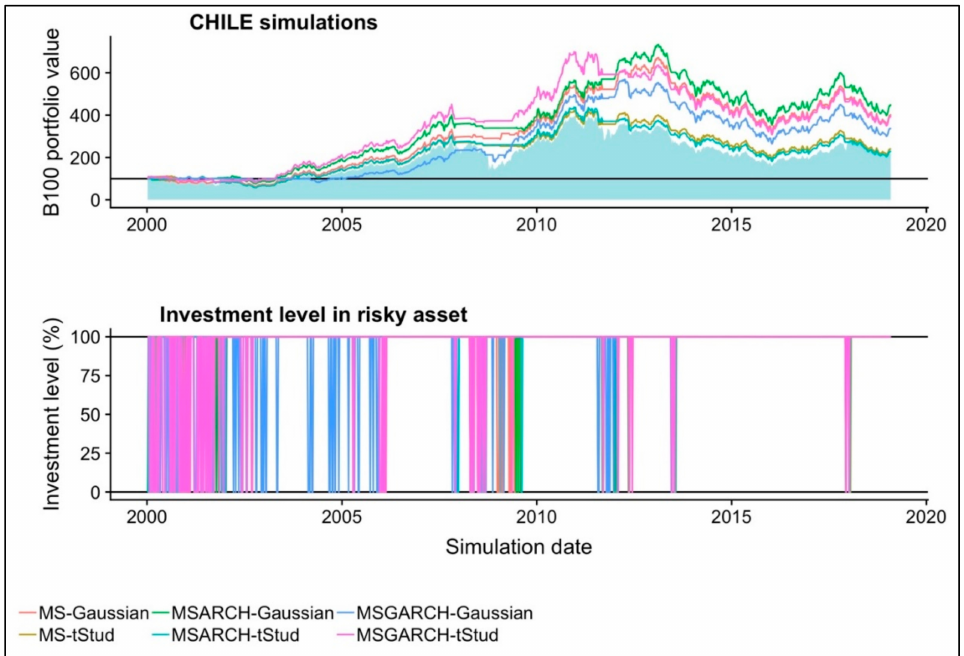
Figure 2. The historical performance of the six backtested portfolios in the Chilean stock